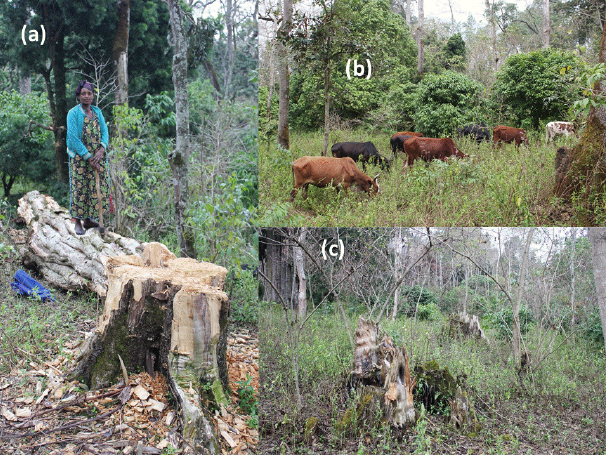
Similarly, the quantity of biomass used as livestock feed tended to be lower in the distant zone compared with the two other zones, but the differences were not statistically significant (Table